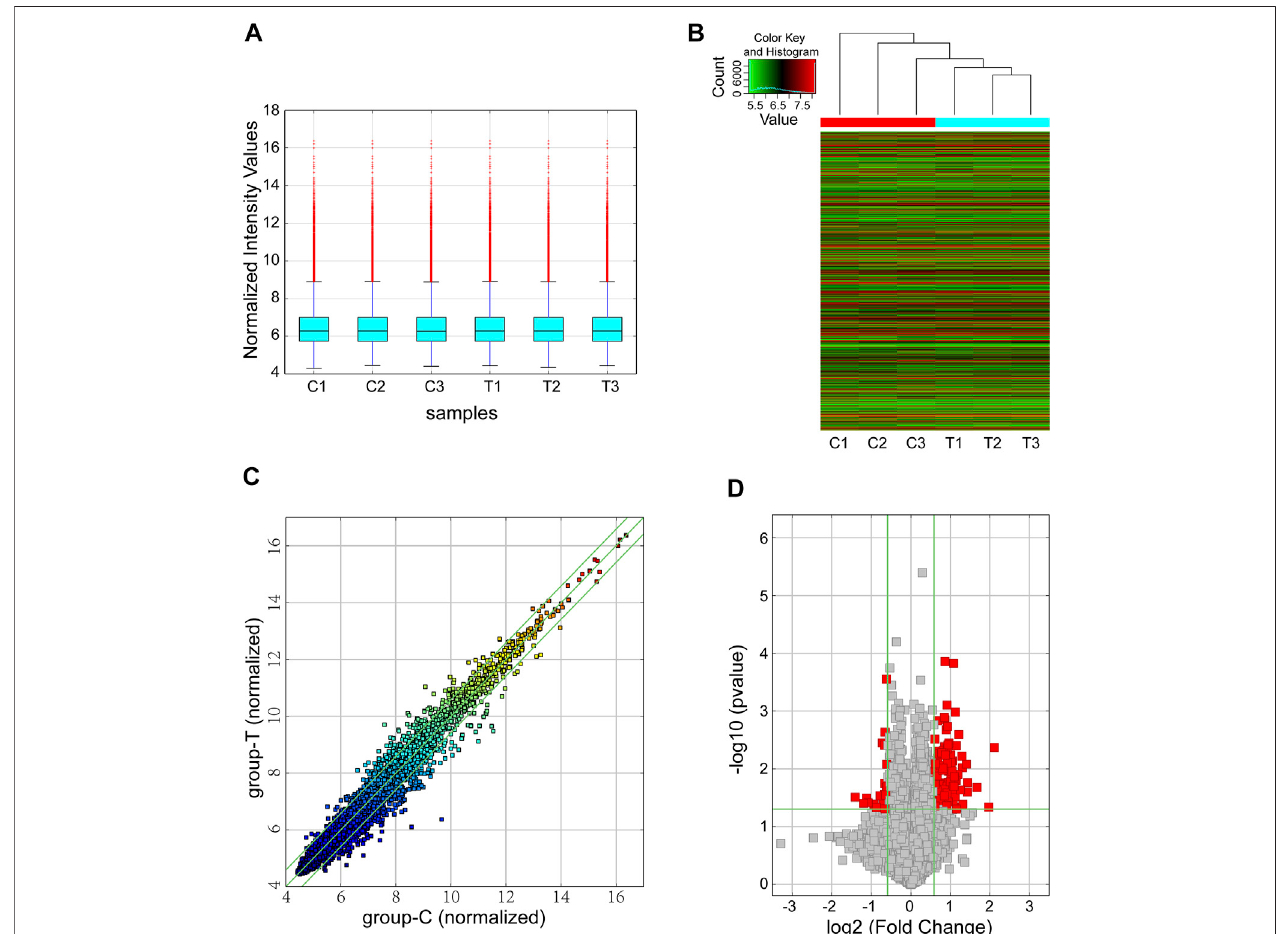
FIGURE 1 | Overview of the microarray signatures. (A) The box plot was performed to show the pro fi le distributions of the normalized intensities. (B) Hierarchical clustering revealed the differentially expressed circRNAs between the CIH groups and controltissues. (C) The scatter plot demonstrated the variation ofthe differentially expressed circRNAs between the two groups. The green lines represented 1.5-fold changes. circRNAs below or above the green lines indicated > 1.5-fold downregulation orupregulationbetweenthe twocompared groups. (D) Differentially expressed circRNAs were displayed by using volcanoplot. The vertical green lines represented a 1.5-fold down or up, respectively. The horizontal green line exhibited a p value of 0.05 (-log10-scaled). The red squares indicated the dysregulated circRNAs with signi fi cant difference. CIH, chronic intermittent hypoxemia.